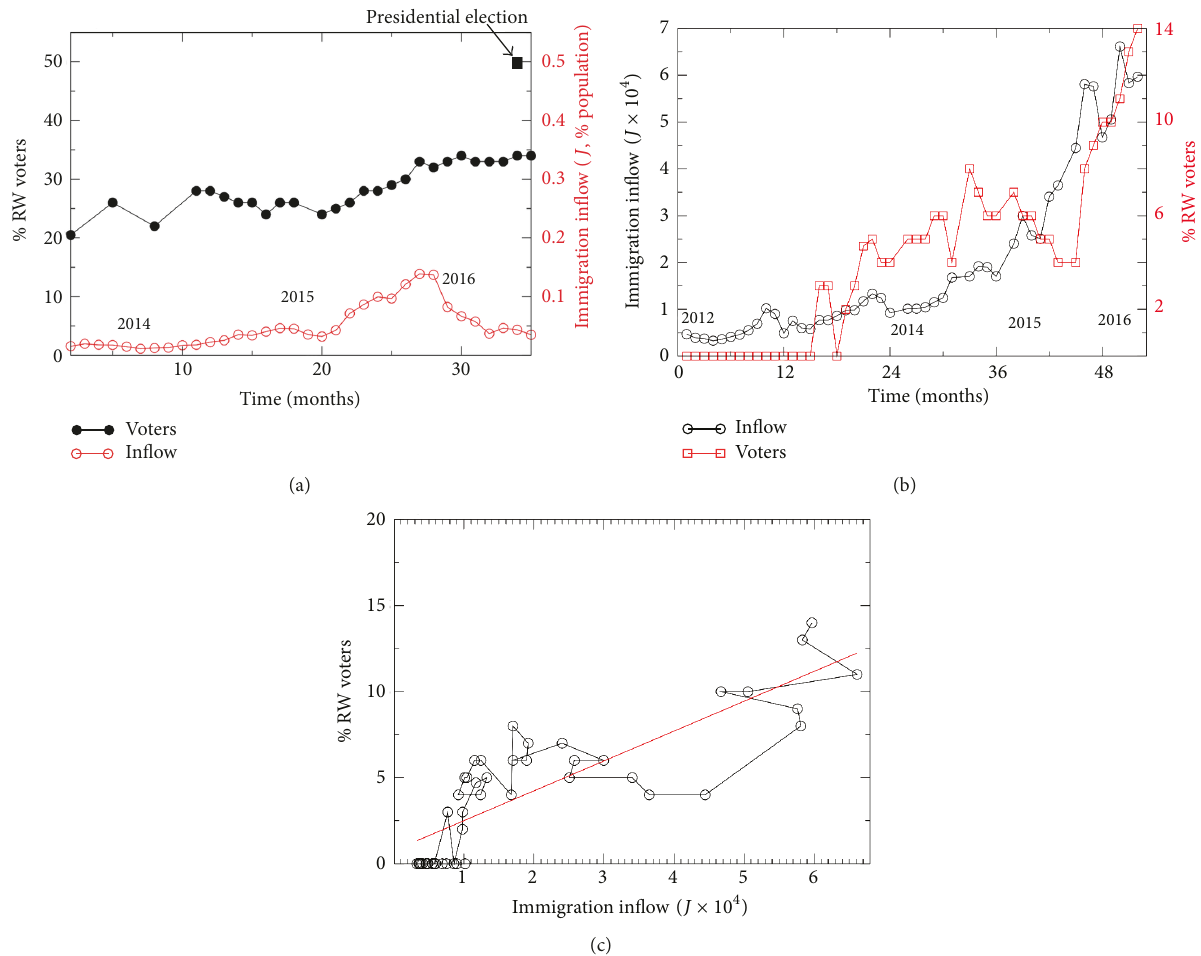
Figure 2: Immigration affects the support for right-wing populism II . (a) An unprecedented inflow of immigrants into Austria coincided with a steady increase in the fraction of RW populist voters. A solitary black dot represents the results of Austrian presidential election in May 2016 in which an RW populist candidate secured almost 50% of votes. This election shows that even after the record immigrant inflow at the end of 2015 had subsided, a decreasing trend in the number of immigrants that enter Austria did not automatically translate into lower support for the RW populist political option, that is, RW populism seems to be more than just a craze. (b) In Germany, the increasing inflow of immigrants (monthly data [34, 35]) rather clearly coincided with the increasing support for an RW populist party. (c) A significant regression emerges when the German case is presented as a scatter plot between the inflow of immigrants and the percentage of far-right